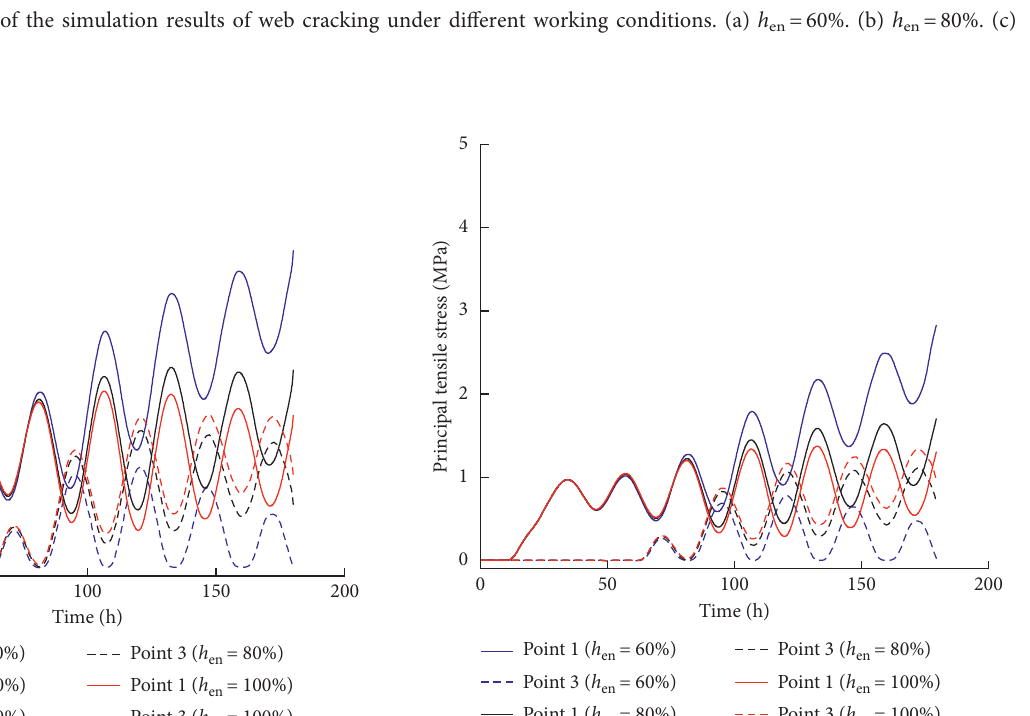
� 60%. (b) h � 80%. (c) en en